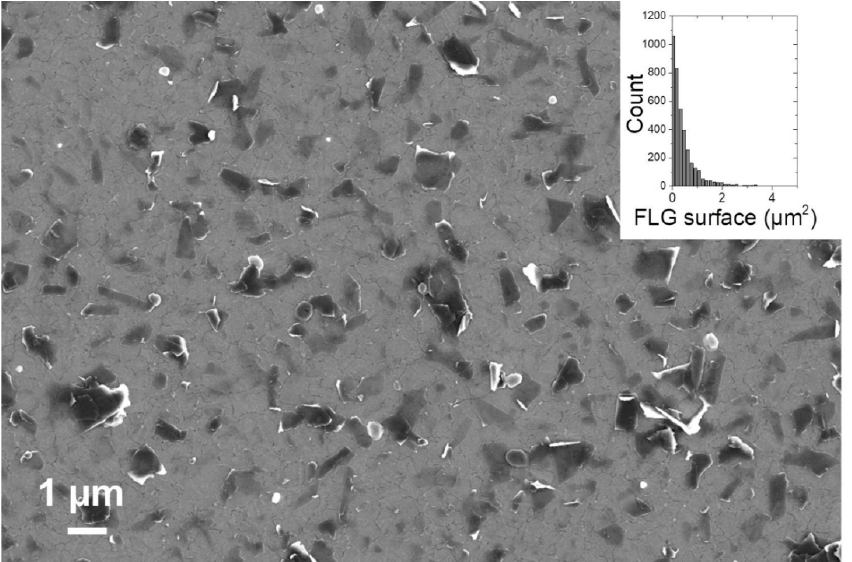
Figure 3. SEM image of biofunctionalized FLG at the surface of a gold electrode; (inset) size distribution of biofunctionalized FLG obtained by ImageJ .